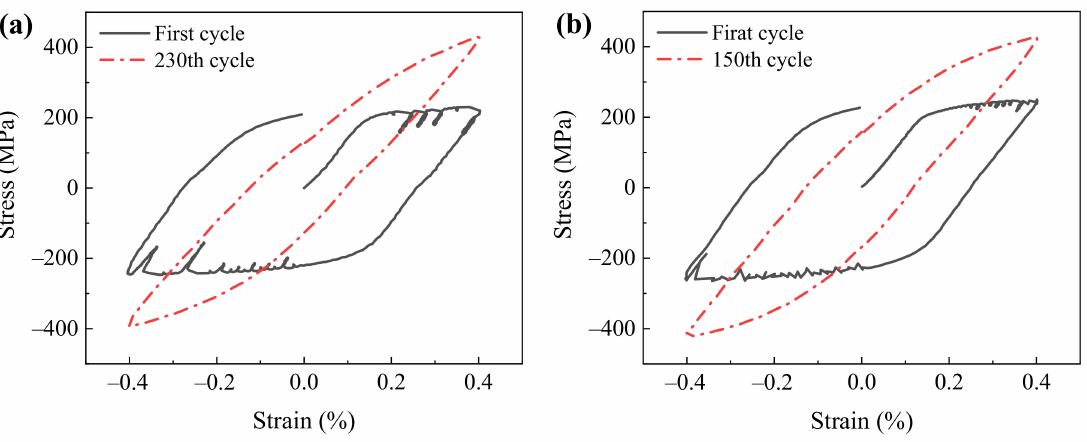
. ε = 1.6 × 10 − 4 s − 1 ) at ( a ) 700 ◦ C and ( b ) 800 ◦